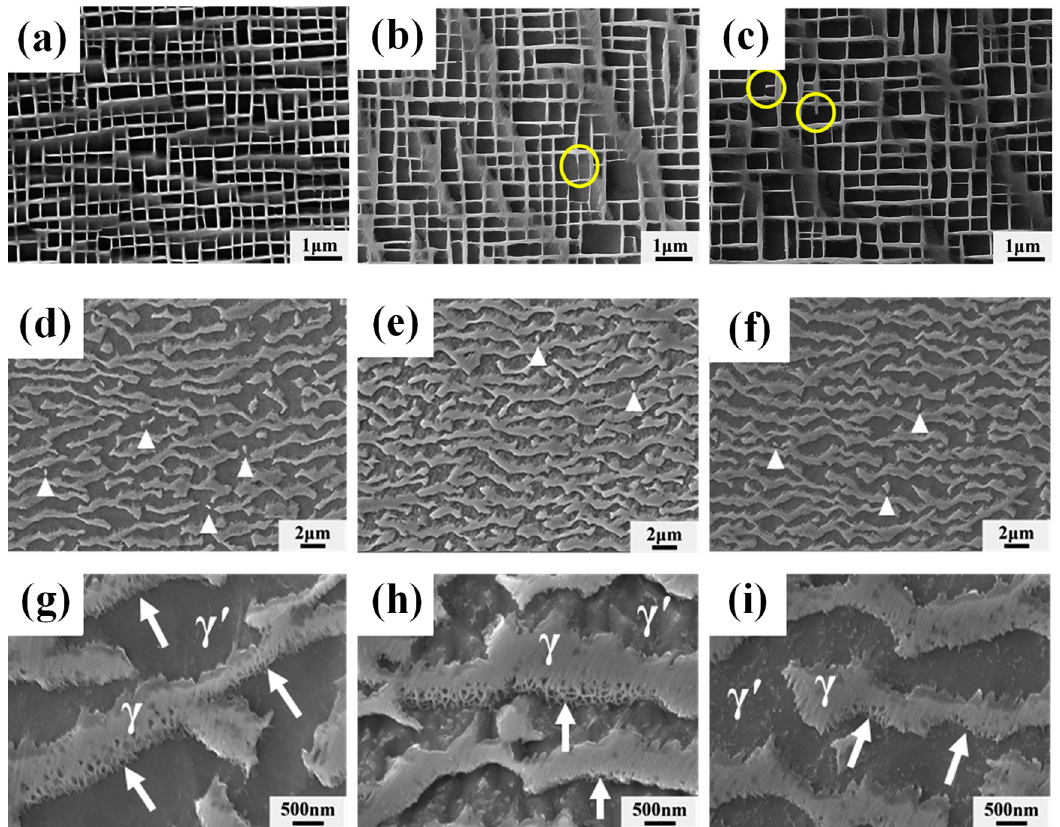
Figure 8. Scanning electron microscopy (SEM) images of microstructures after aging at 1000 °C for ( a ) 100 h, ( b ) 500 h, and ( c ) 1000 h. SEM images of microstructures aged at 1000 °C for ( d , g ) 100 h, ( e , h )